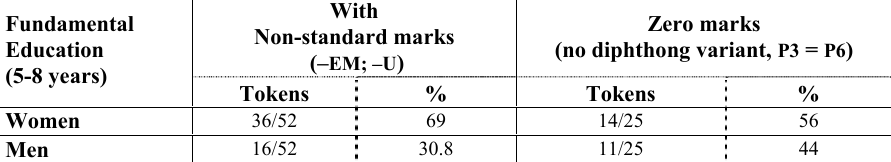
Table XI: Non-standard and absence of third person plural verbal marking and Sex/Gender in Fundamental level Education – Funchal (EP)